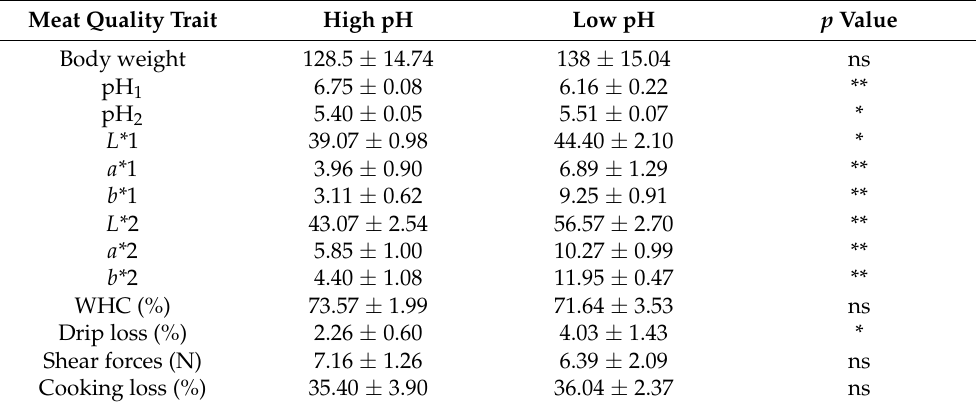
Table 1. Quality traits of porcine longissimus thoracis et lumborum (LTL) muscle with different pH